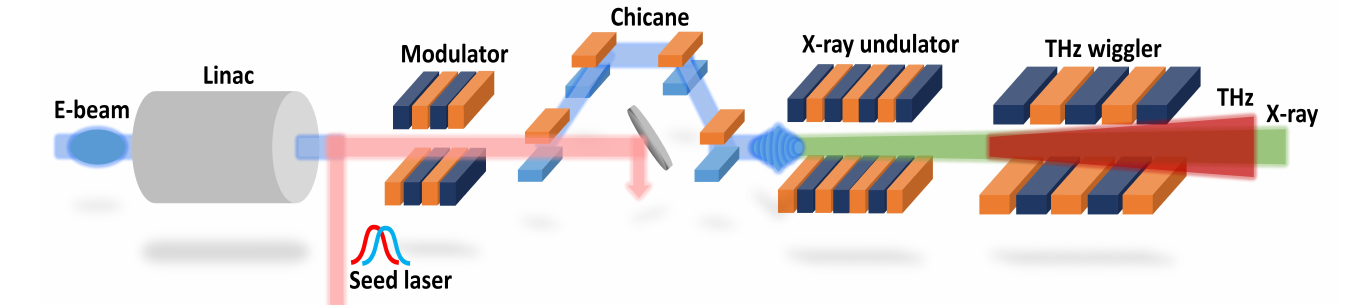
Figure 2. The layout of the proposed technique.